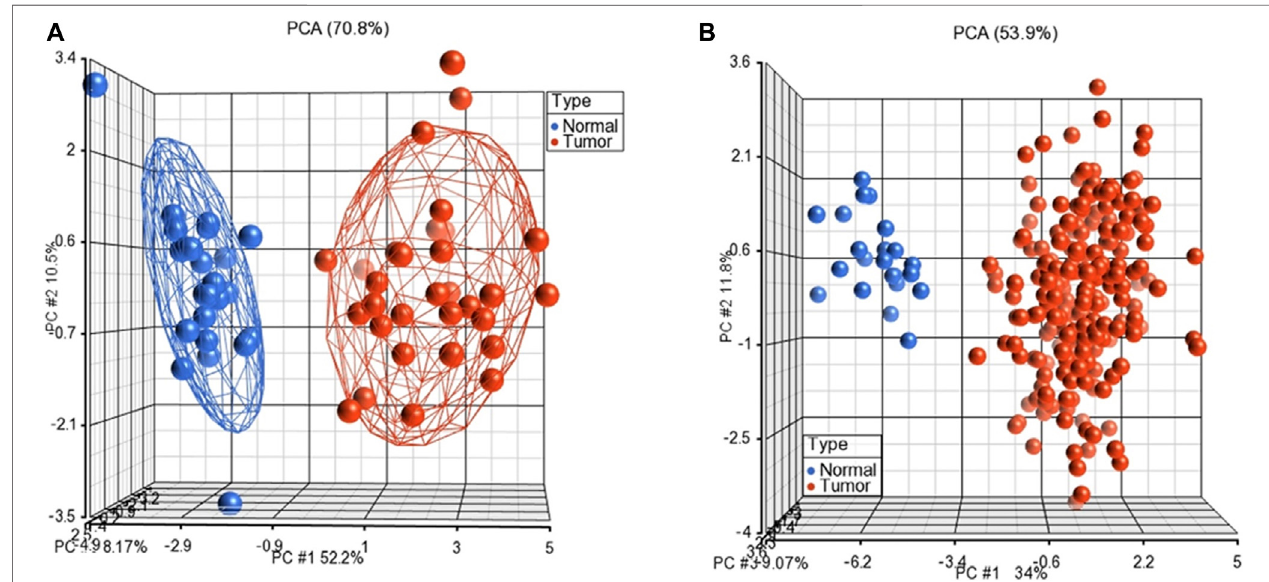
FIGURE 3 | Unsupervised principal component analyses (PCAs) discriminates samples as tumors and normal controls on GSE23878 (A) and TCGA (B) . The red spheres refer to tumors and blue ones for normal controls.